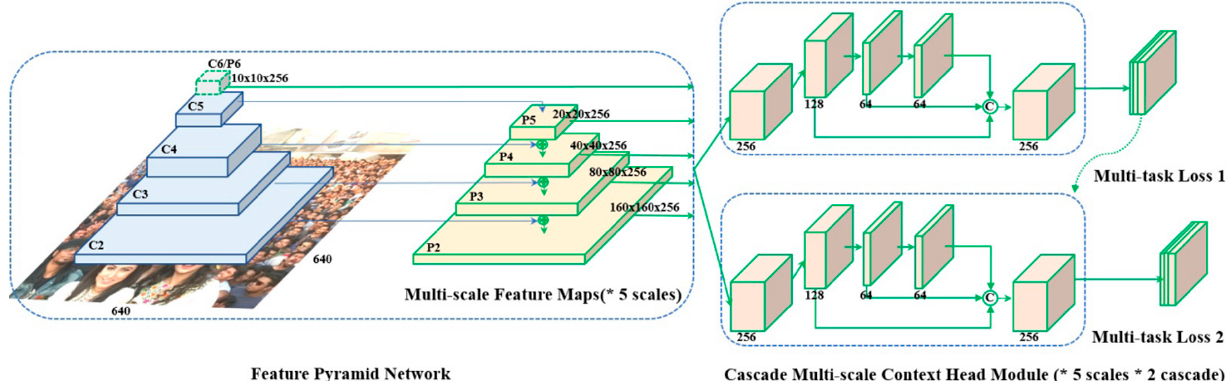
Figure 3. RetinaFace detector.